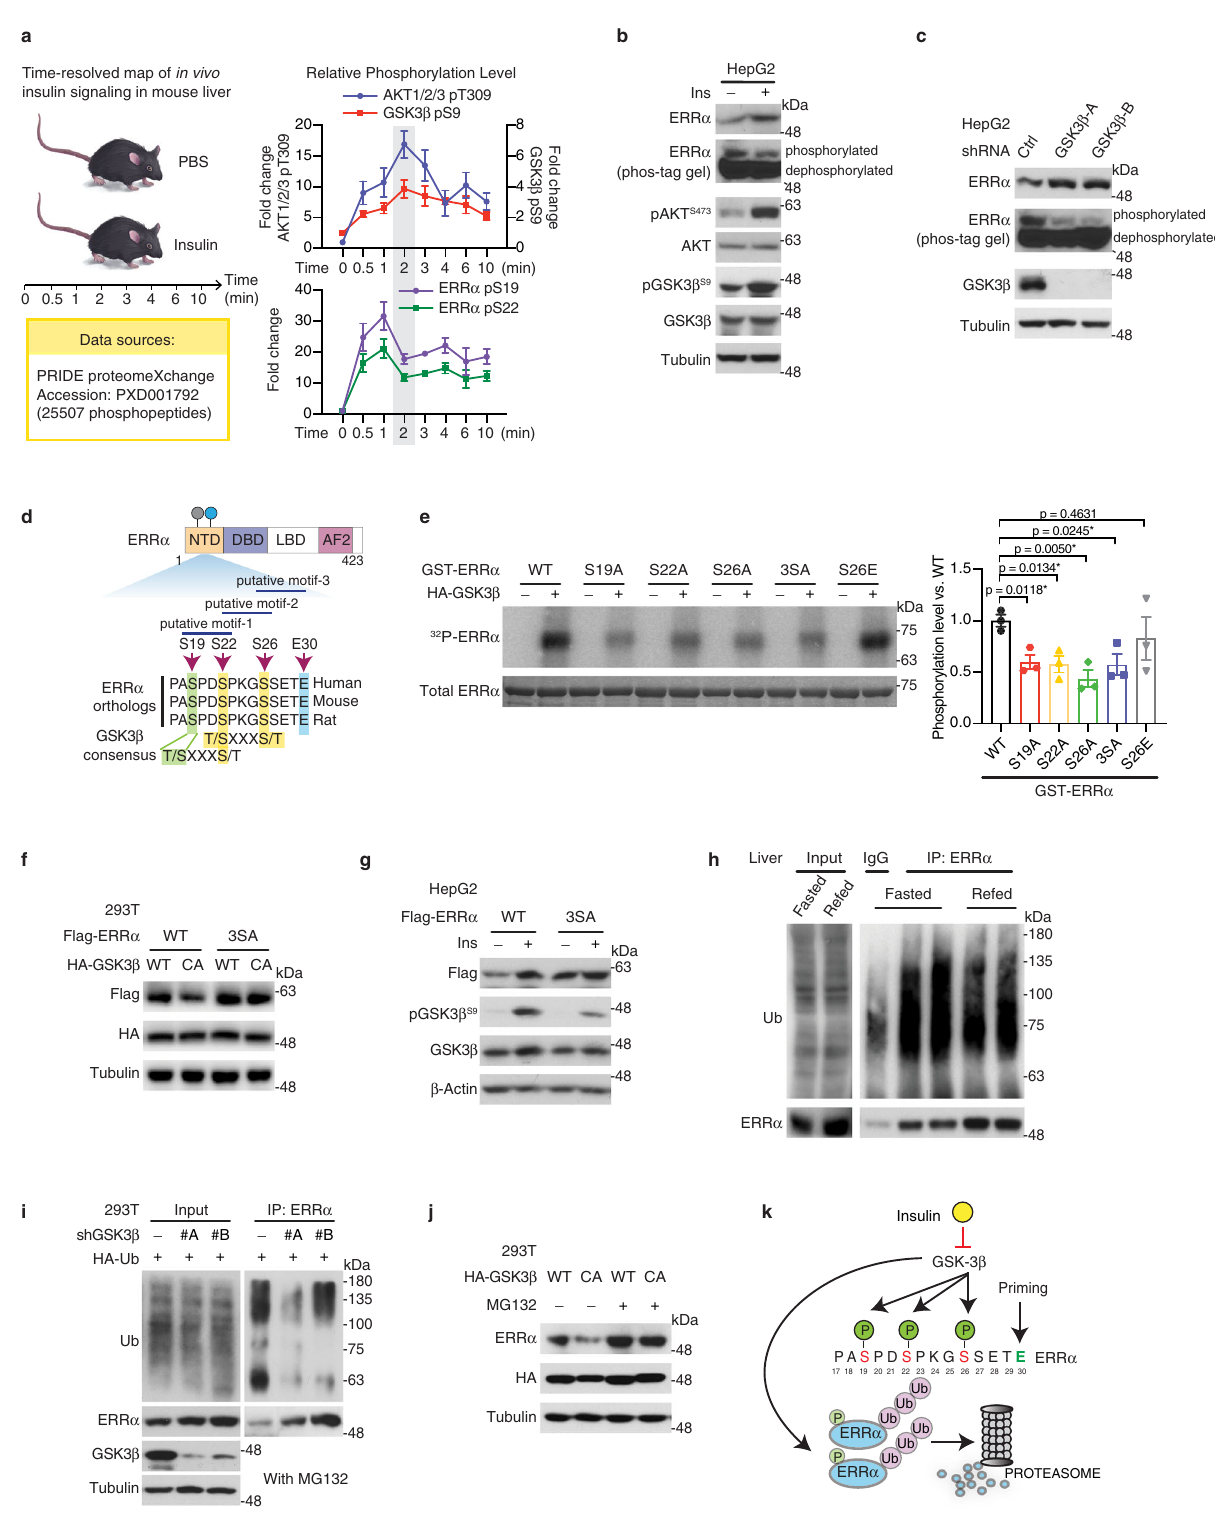
between the 6 E3 candidates and ERR α (Supplementary Fig. 4e). Of these, 4 E3s were further demonstrated to enhance ERR α ubiqui- tination (Supplementary Fig. 4f), while their shRNA-mediated knockdown fostered ERR α accumulation (Supplementary Fig. 4g). Overall, the screen uncovered 4 E3 ligases (FBXO7, FBXO11, FBXW7 α and WWP1) directly targeting ERR α for ubiquitination and